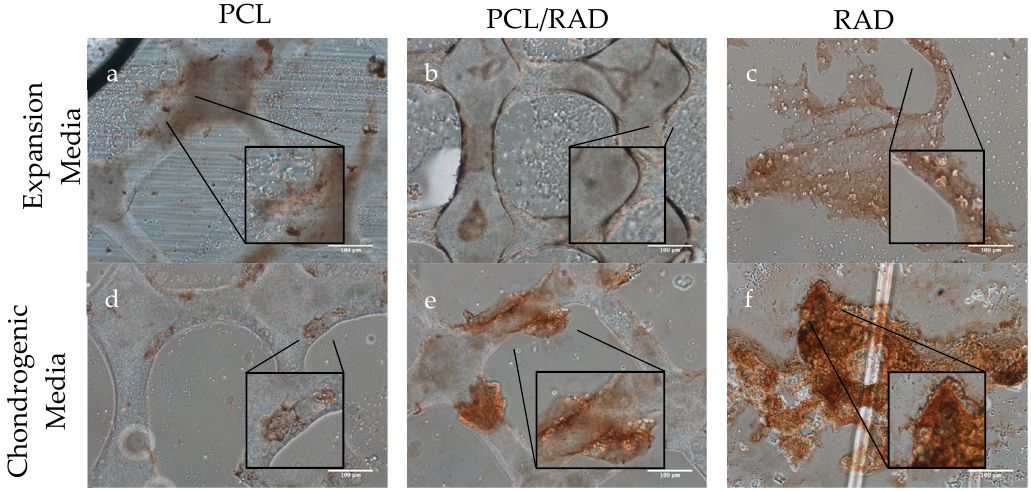
Figure 8. Immunohistochemistry composite picture of collagen type II staining. ( a – c ) PCL, PCL/RAD and RAD samples cultured in expansion medium. ( d – f ) PCL, PCL/RAD and RAD samples cultured in chondrogenic medium. Scale bar = 100 µm. n = 3.